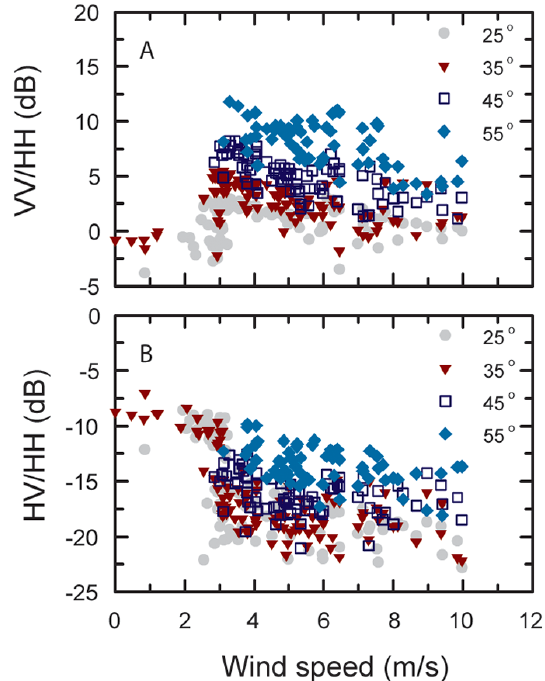
Figure 7. Polarisation ratios VV / HH (a) and HV / HH (b) versus wind speed ( U 10 ) at 10 ◦ incidence angle intervals from 25 to 55 ◦ . Samples were taken from Database